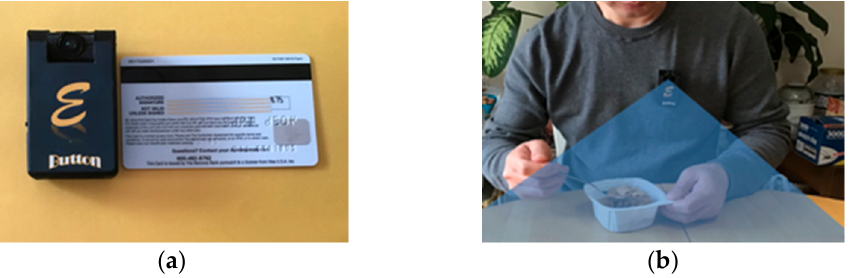
Figure 1. ( a ) The eButton is less than half the size of a credit card; ( b ) eButton takes pictures auto- matically during an eating